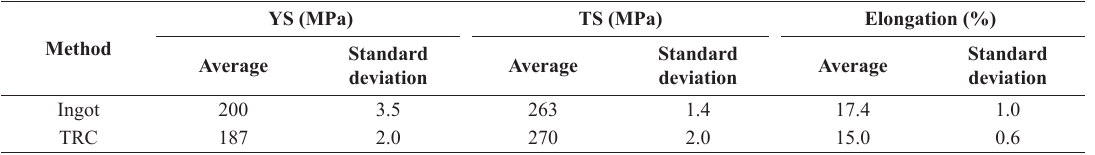
Table 1. Tensile properties of the annealed